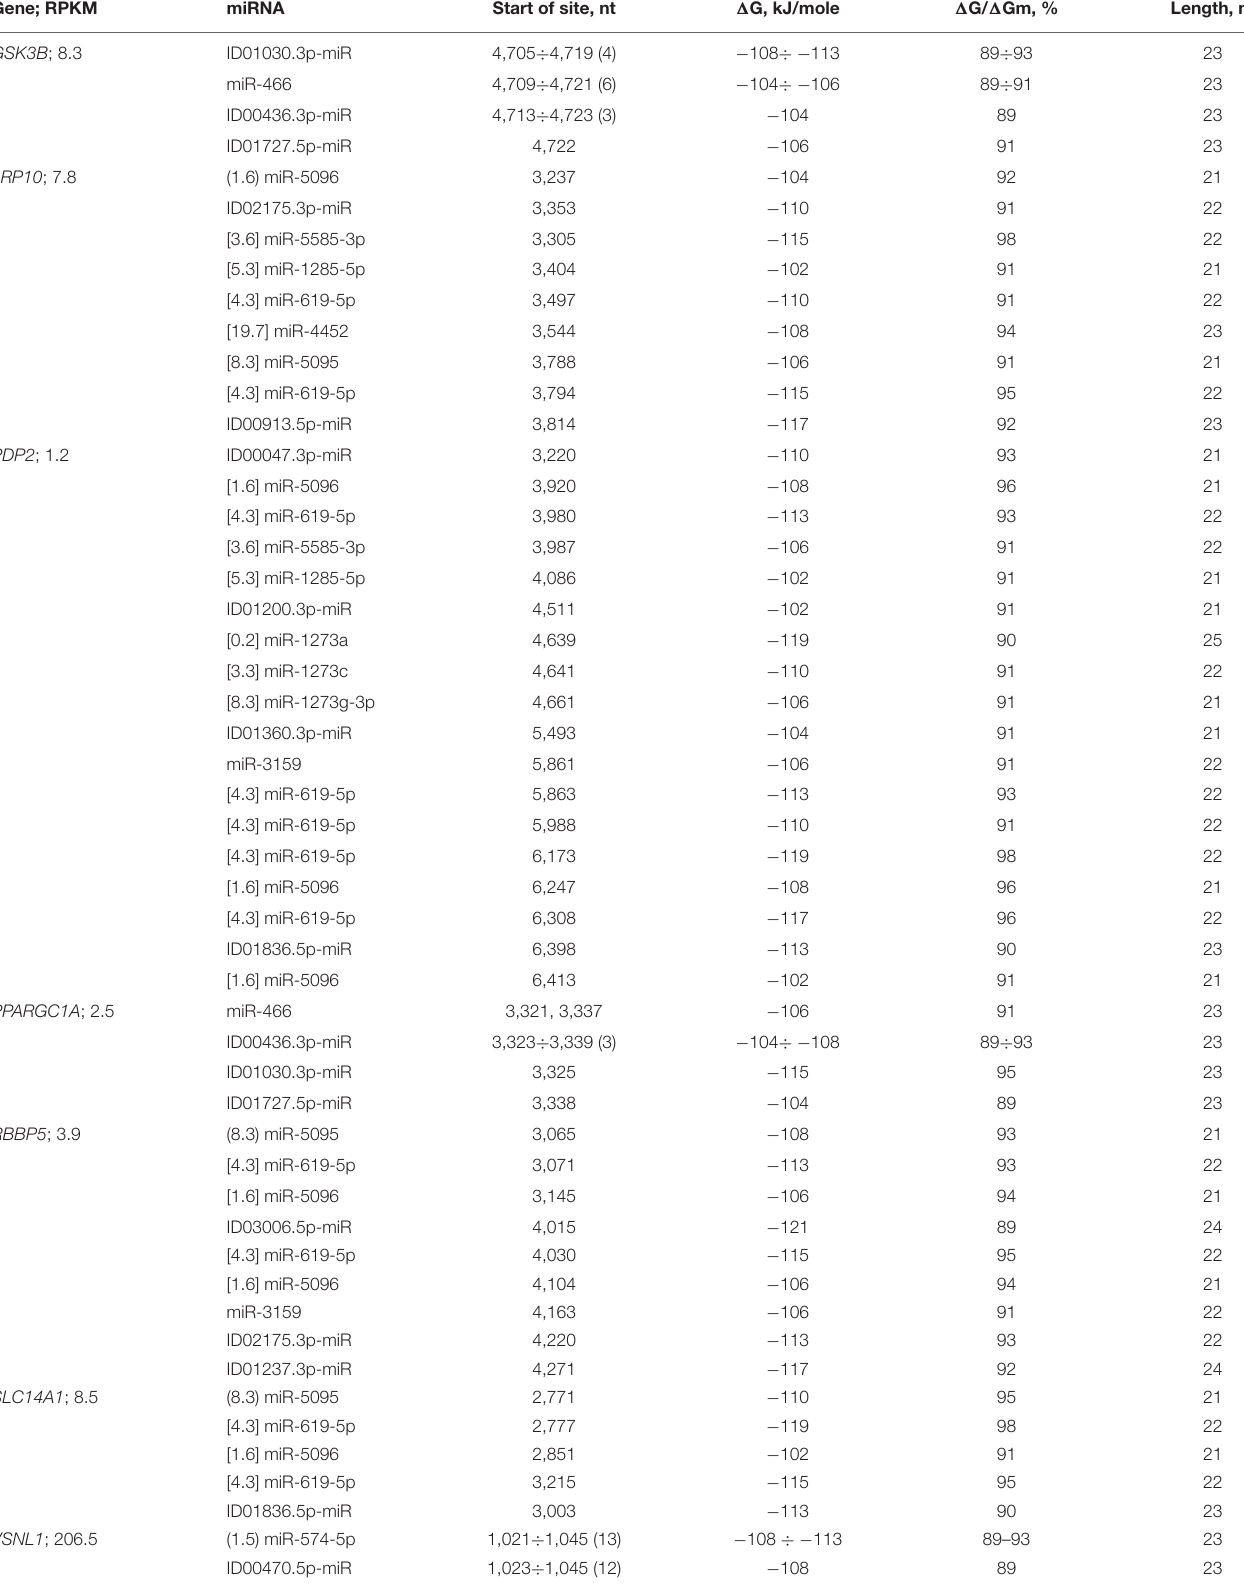
TABLE 3 | Characteristics of the interactions between miRNAs and the 3 (cid:48) UTR mRNAs of candidate PD genes. Gene; RPKM miRNA Start of site, nt (cid:49) G, kJ/mole (cid:49) G/ (cid:49) Gm, % Length, nt GSK3B ; 8.3 ID01030.3p-miR 4,705 ÷ 4,719 (4) − 108 ÷ − 113 miR-466 ID00436.3p-miR 4,713 ÷ 4,723 (3) ID01727.5p-miR 23 LRP10 ; 7.8